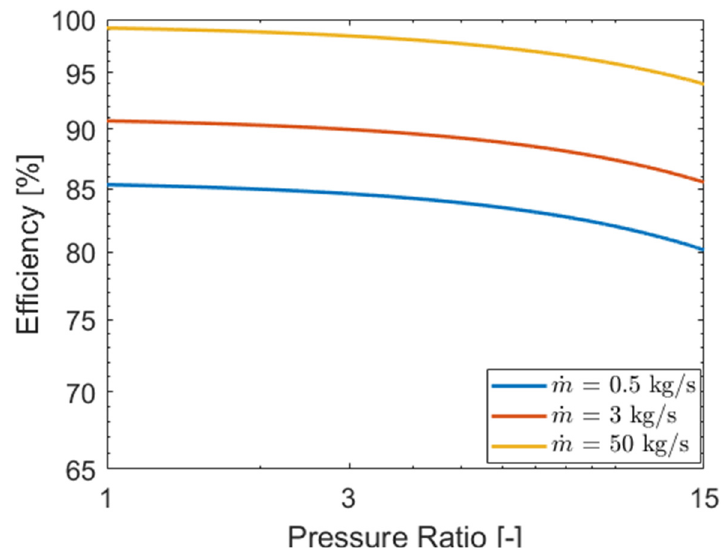
Figure 4. Compressor Polytropic Efficiency calculated using Equation (4).